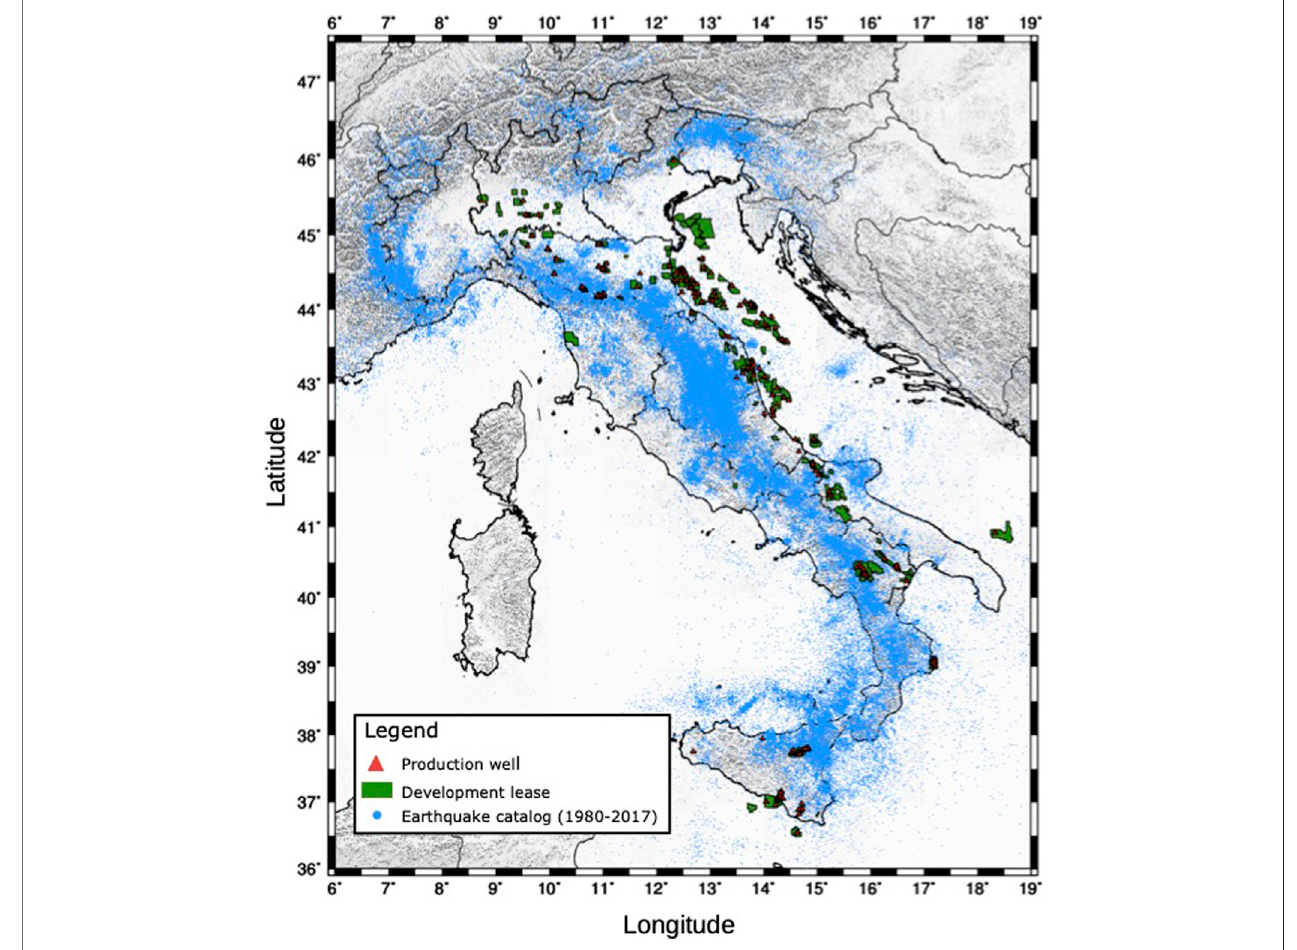
FIGURE 1 | Map showing the spatial distribution of the oil and gas production leases in Italy, as well as the epicenters ofthe earthquakes from the HORUS catalog used in this study.